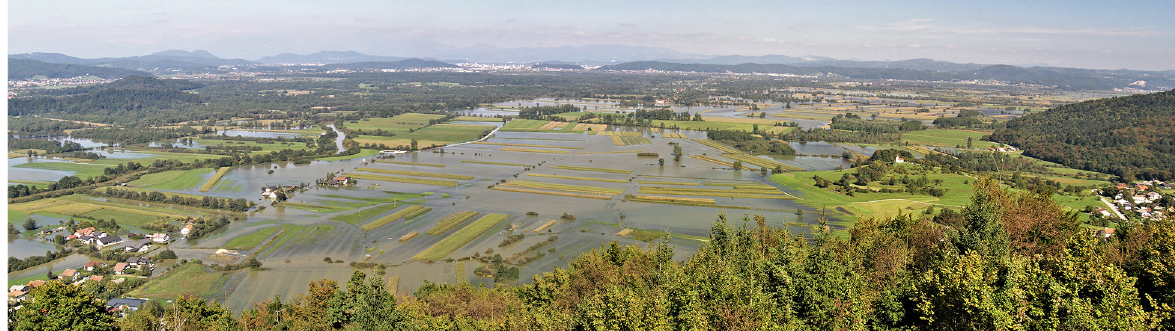
Fig. 5. Periodic floods are one of major restrictive factors for urbanization of the Ljubljana Marsh area (photo: B.